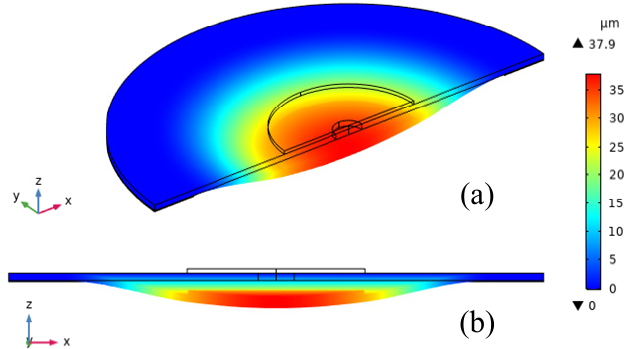
Figure 2. Simulation results of the vertical displacement with a piezoelectric force of 7 N and a differential pressure of 200 kPa. ( a ) Three-dimensional view. ( b ) z–x plane view.